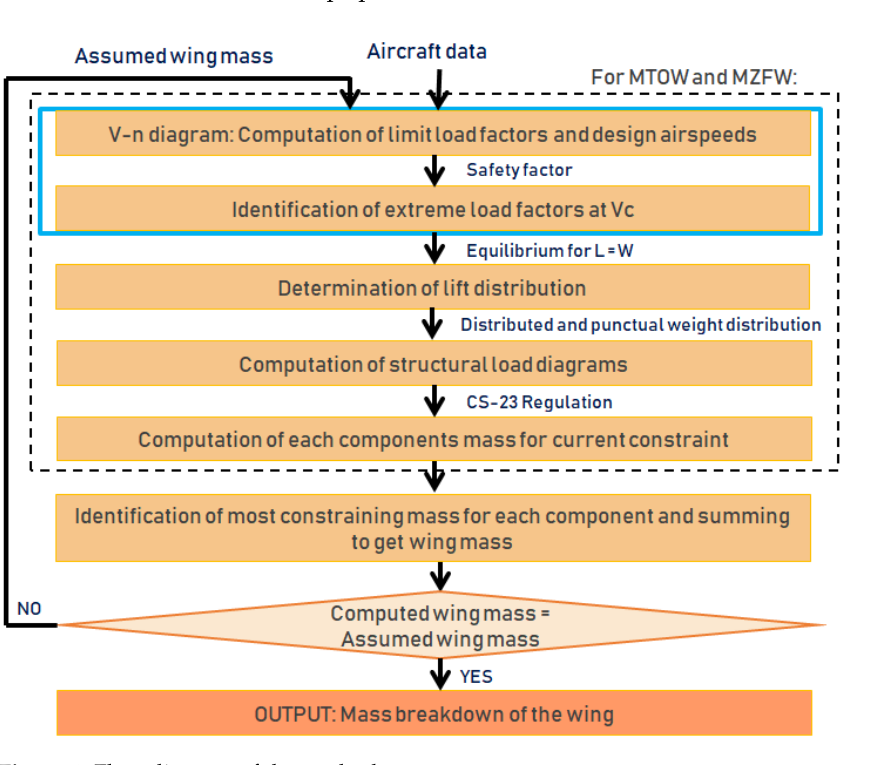
Figure 4. Flow diagram of the